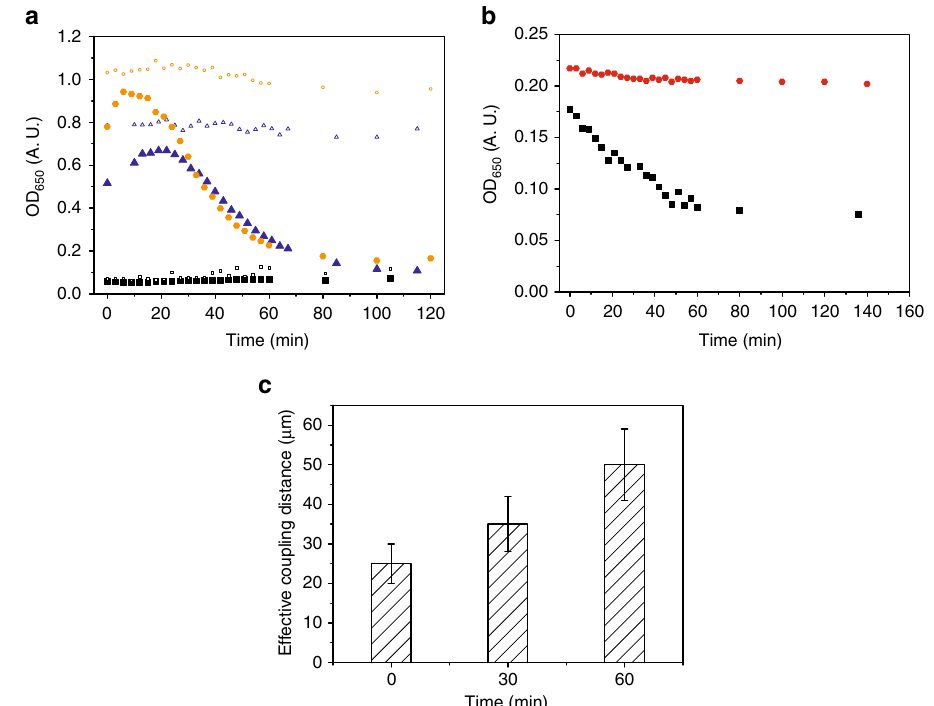
Fig. 3 The effective mechanical coupling after cell lysis. a Cell lysis of exponentially grown B. subtilis wt cells in SYM at different initial optical densities at room temperature ( fi lled symbols) or at 4 °C (open symbols). b Cell lysis of stationary ( fi lled red circles ) and exponential ( fi lled black squares ) B. subtilis cells re-suspended in PBS. c The effective mechanical coupling of B. subtilis wt cells during cell lysis. The average values and standard deviations are given ( n =